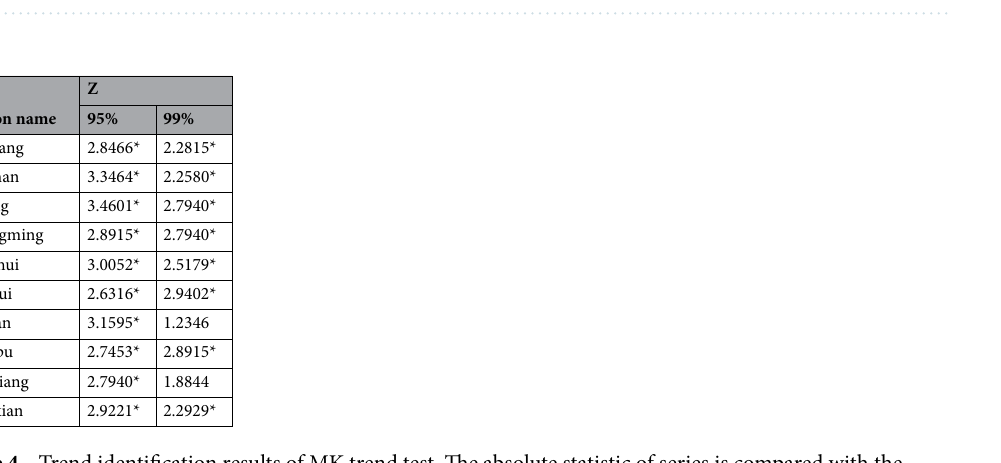
Table 4. Trend identification results of MK trend test. The absolute statistic of series is compared with the threshold of 1.96 with 0.05 significance level. If being bigger than 1.96, the trend of the analyzed series is statistically significant (denoted as ‘‘*’’); if being smaller than 1.96, the trend of the analyzed series is not statistically